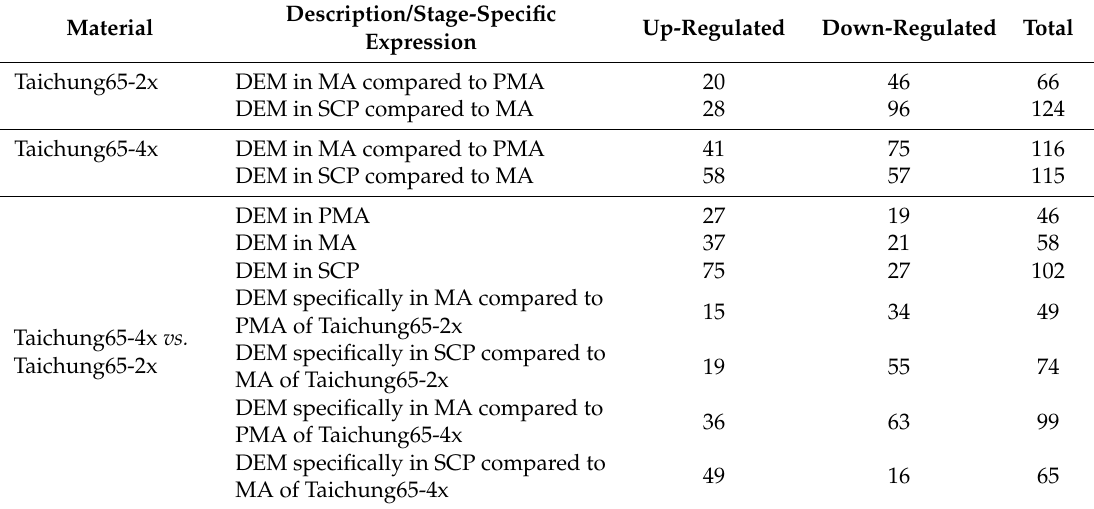
Table 1. Differentially expressed miRNAs (DEM) in autotetraploid rice comparative to diploid rice. Description/Stage-Specific Up-Regulated Down-Regulated Total Material Expression Taichung65-2x DEM in MA compared to PMA 20 46 66 DEM in SCP compared to MA 28 96 124 Taichung65-4x DEM in MA compared to PMA 41 75 116 DEM in SCP compared to MA 58 57 115 DEM in PMA 27 19 46 DEM in MA 37 21 58 DEM in SCP 75 27 102 DEM specifically in MA compared to 15 34 49 PMA of Taichung65-2x Taichung65-4x vs. DEM specifically in SCP compared to Taichung65-2x 19 55 74 MA of Taichung65-2x DEM specifically in MA compared to 36 63 99 PMA of Taichung65-4x DEM specifically in SCP compared to 49 16 MA of Taichung65-4x